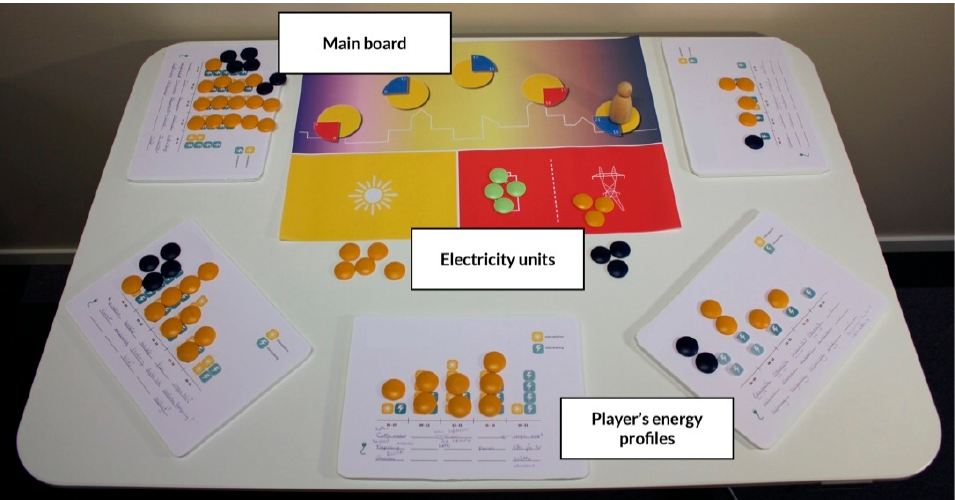
Figure 2. A photo of the components of the microgrid board game.